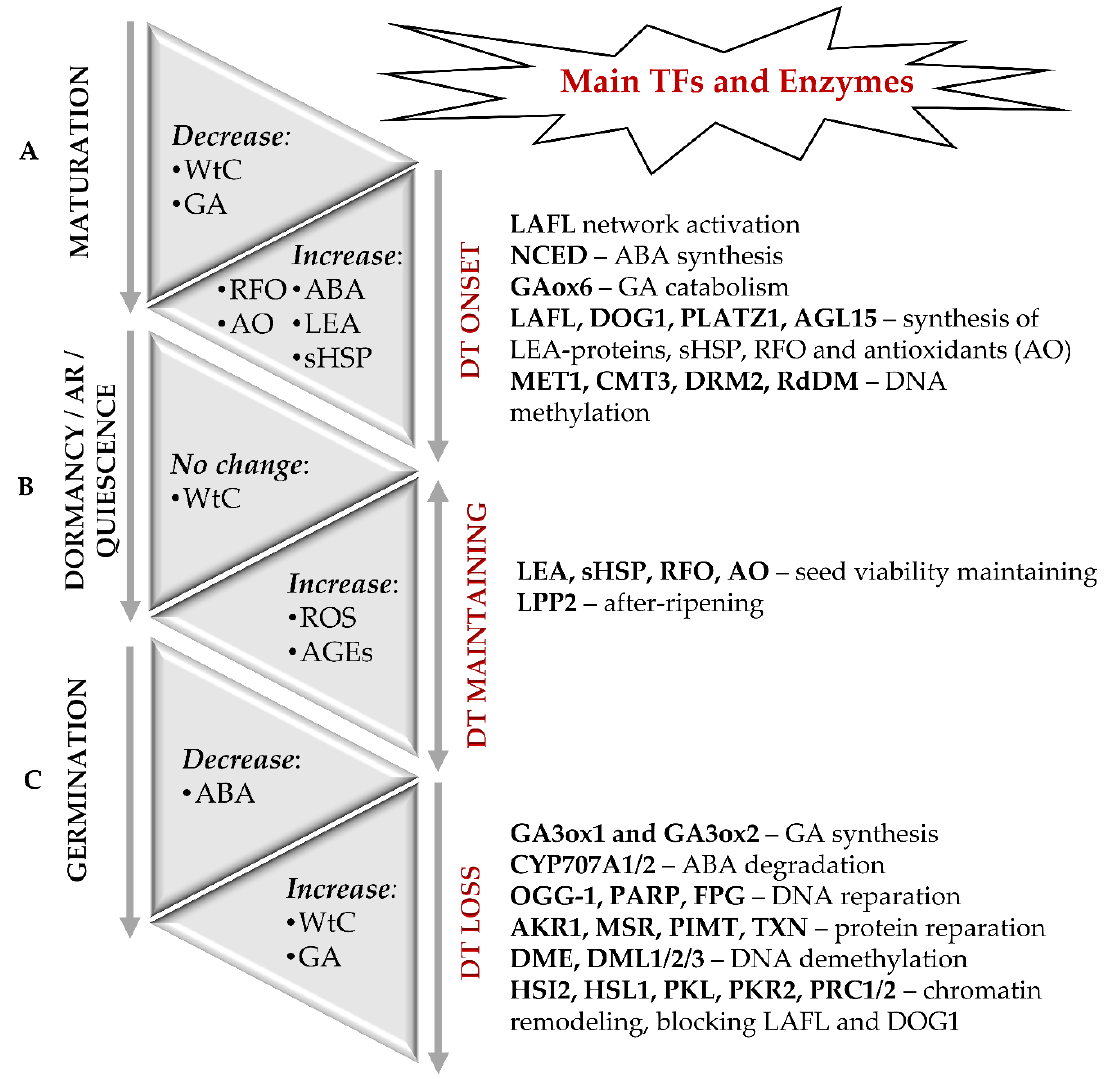
Figure 1. Molecular events accompanying the onset and loss of desiccation tolerance (DT) in orthodox seeds. ( A ) The onset of DT and seed dormancy is defined during the late maturation stage and associated with a sharp decrease in water content (WtC). The molecular basis of DT is the accumulation of LEA proteins, sHSP, RFO, and antioxidants. Regulation of seed FUS3 and LEC2, as well as by DOG1, DOG4 and DOGL4 proteins. In addition to the transcription factors of LAFL